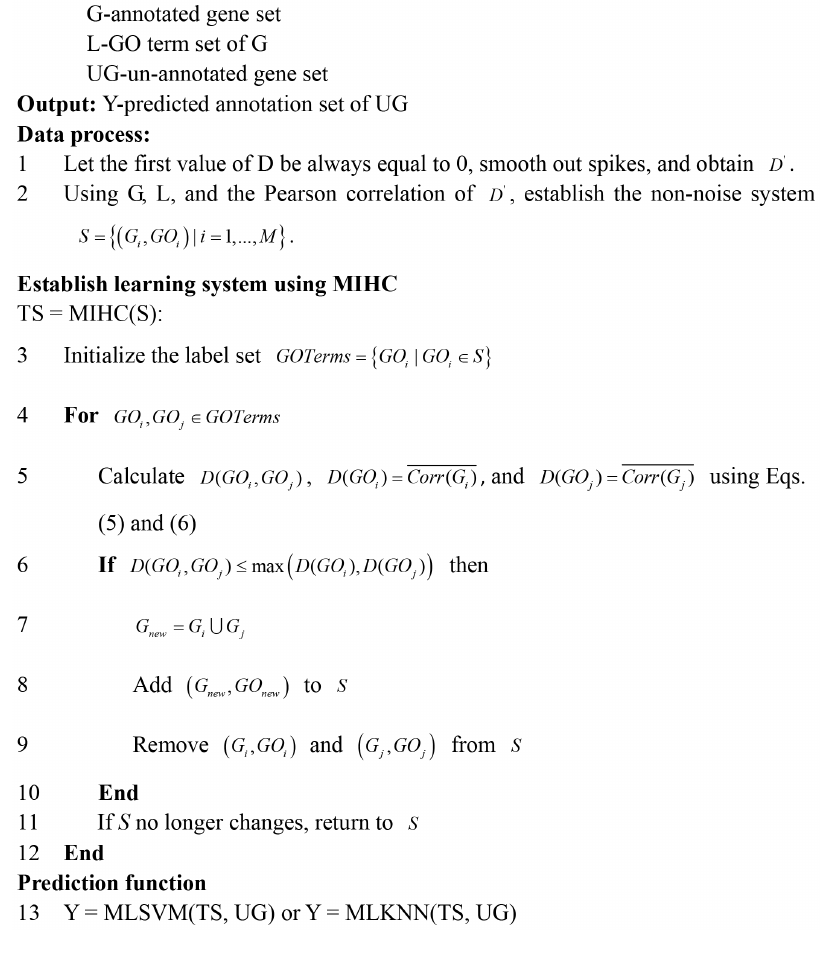
Figure 3. MIHC algorithm and flow chart of function prediction.